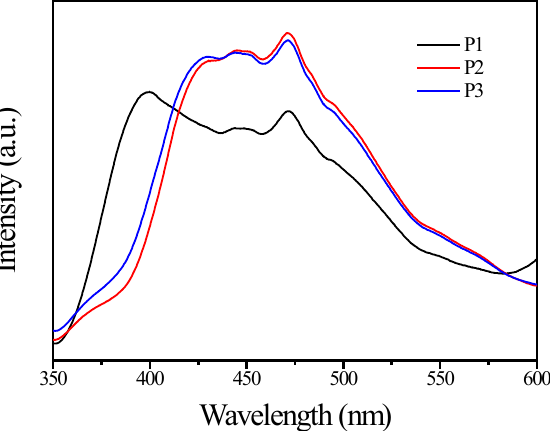
Figure 5. PL spectra of the samples with the excitation wavelength of 300 nm.